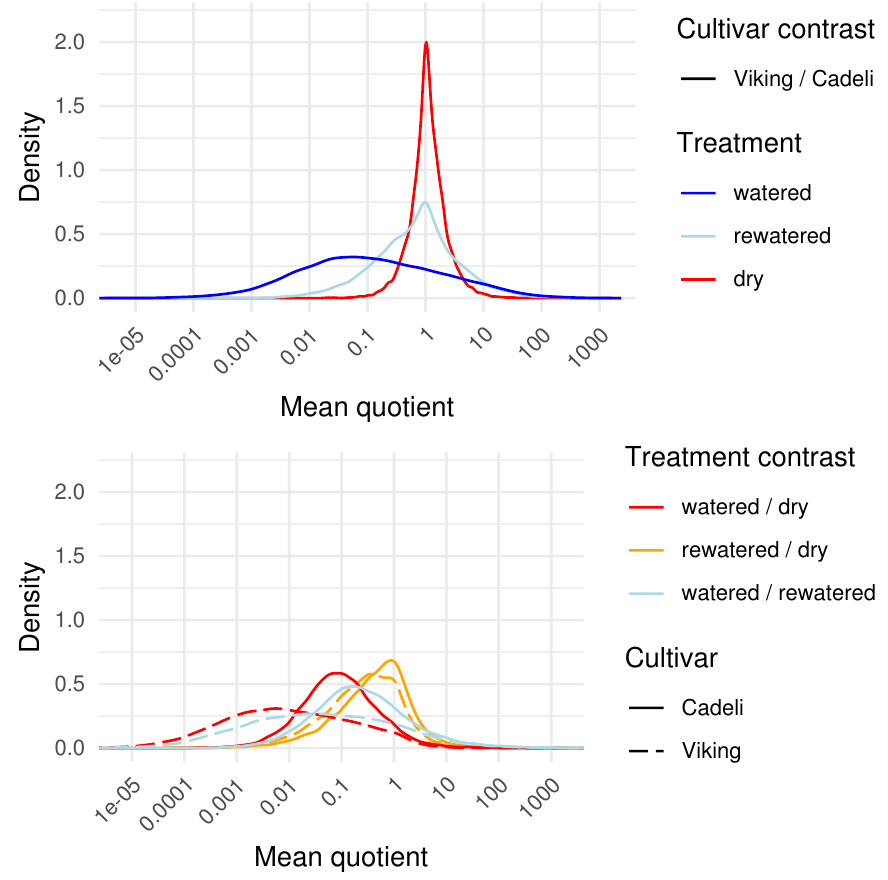
Figure 5. Posterior distributions of the mean dry pixel frequency differences between the experimental factors. Each curve represents one contrast. The differences are assumed to be multiplicative. The top subplot depicts comparisons between the cultivars and the bottom plot comparisons between watering regimes. The effect sizes are on a logarithmic scale centred at the value of 1 (lack of